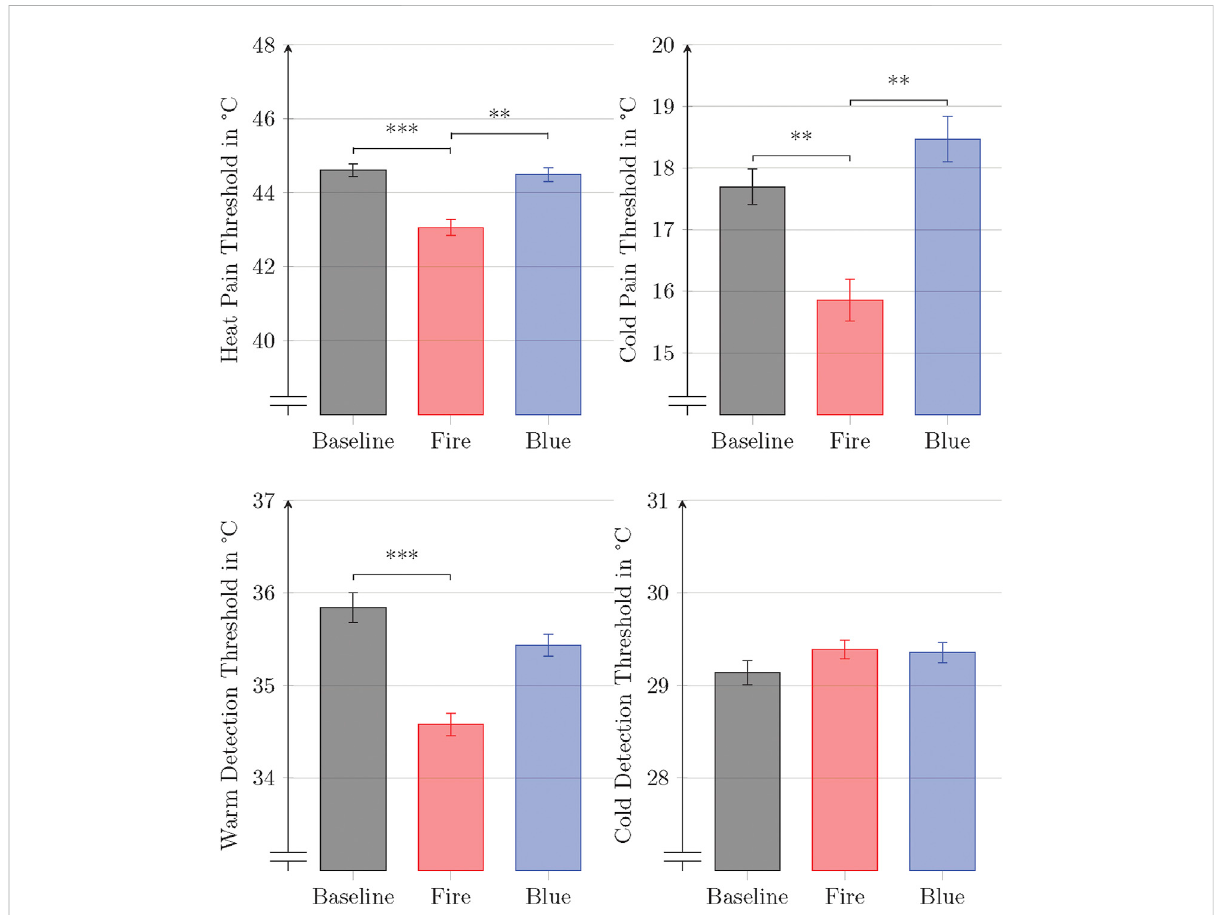
FIGURE 2 Mean thermal pain and detection thresholds for each condition. The whiskers denote the standard error. Connected bars represent signi fi cant difference * (cid:2) p < .05 , ** (cid:2) p < .01 , *** (cid:2) p < .001.